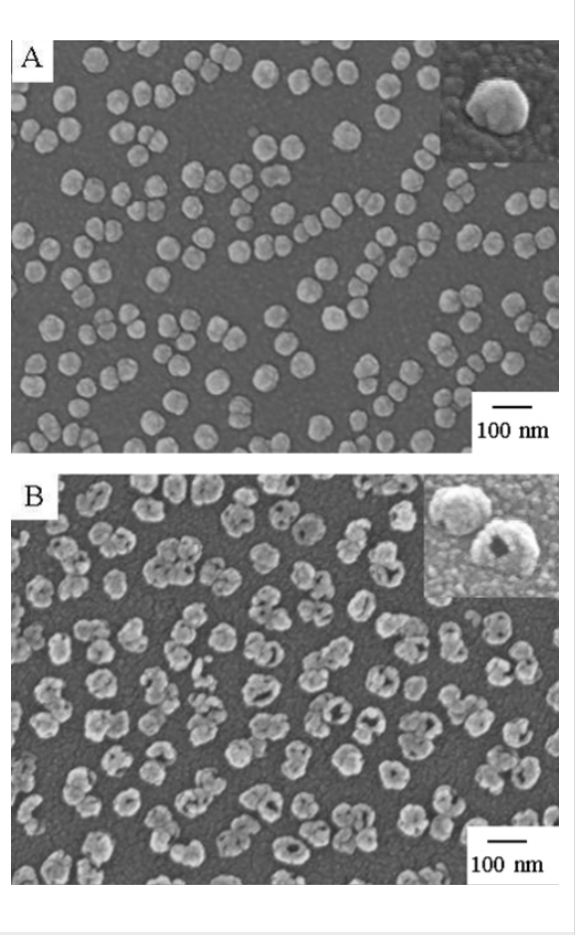
Figure 1: SEM images showing the morphology of AgNP templates before (A) and after (B) galvanic replacement using 0.1 mM HAuCl 4 solution for 2 h with top-view. Insets: tilted-view with tilt angle of